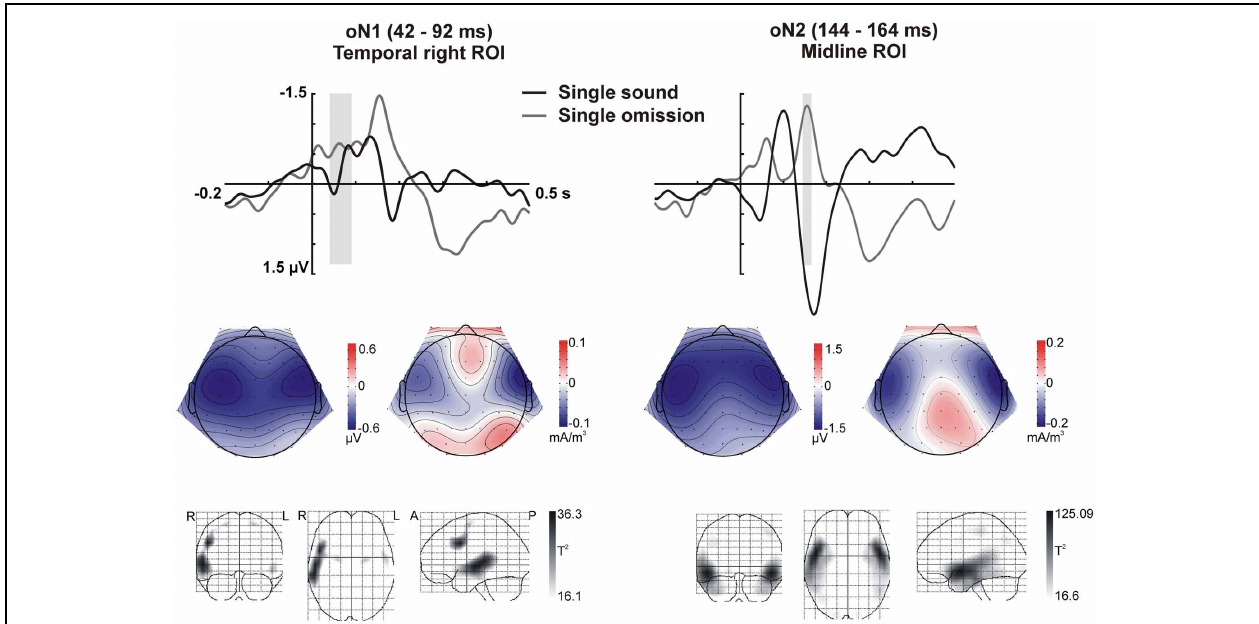
FIGURE 4 | Omission N1 (oN1, 42–92ms) and omission N2 (oN2, 144–164 ms) responses in the single sound condition. The response elicited by sound omissions in the single sound condition in the oN1 (left) and oN2 (right) time-windows is depicted. Top row: ERPs for the temporal right (left) and midline (right) ROIs (averaged over electrodes in the ROI) are plotted for sounds and omissions. Both sound and omission responses are motor-corrected via subtraction of the no-sound motor control waveform. The time-windows defined for the oN1 (left) and oN2 (right) are indicated with gray shading. Middle row: Scalp potential (left maps) and scalp current density (right maps) maps for the motor-corrected omission response in the marked oN1 and oN2 time-windows. Bottom row: Statistical parametric